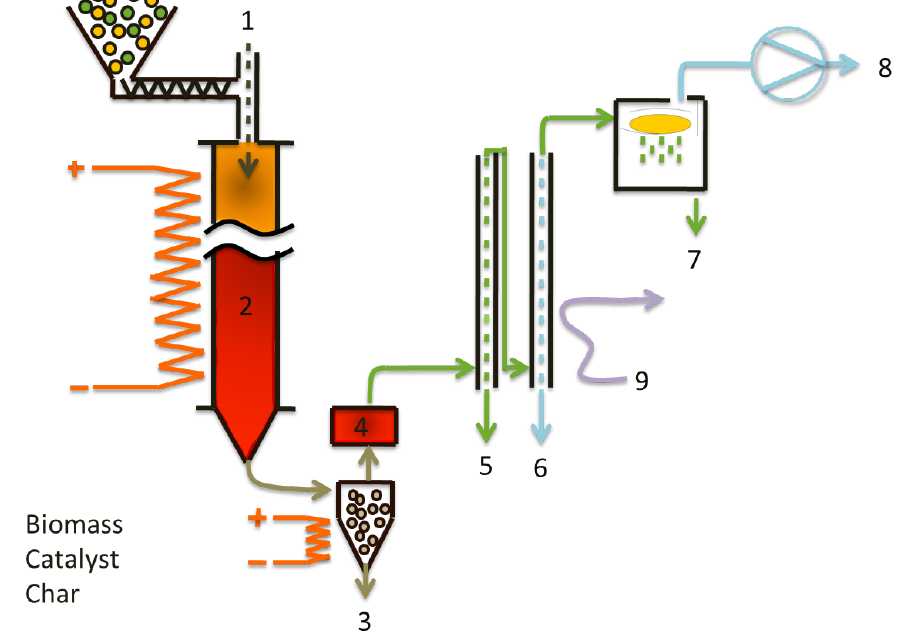
Figure 1. Schematic presentation of the experimental setup; 1. Carrier Gas (N2). 2. Pyrolysis Reactor. 3. Solids recovery. 4. Hot particle filter element. 5-6-7. Liquid collection. 8. Gas to analysis unit.